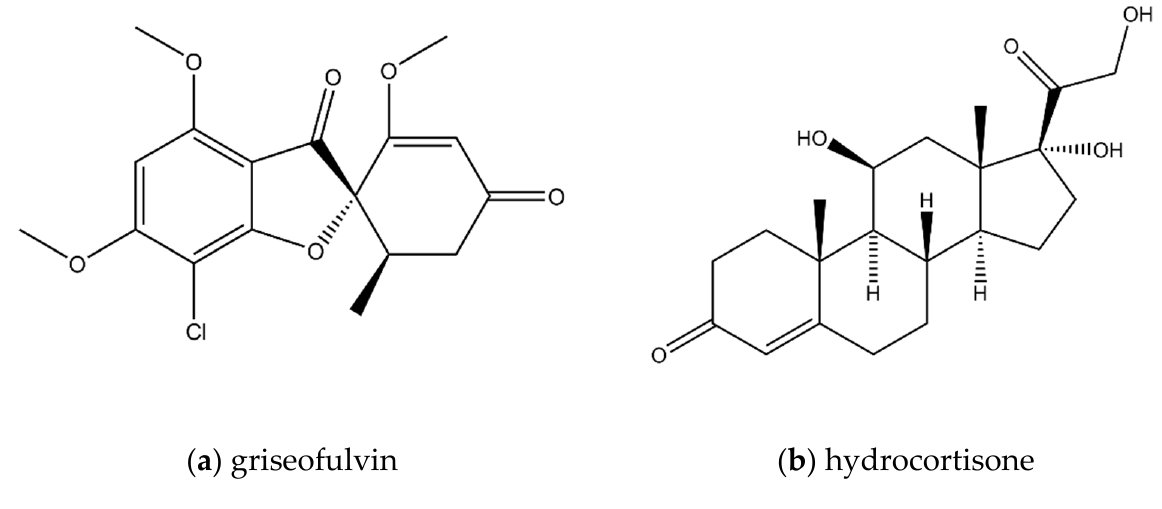
Figure 1. The molecular structure of: ( a ) griseofulvin; ( b ) hydrocortisone.